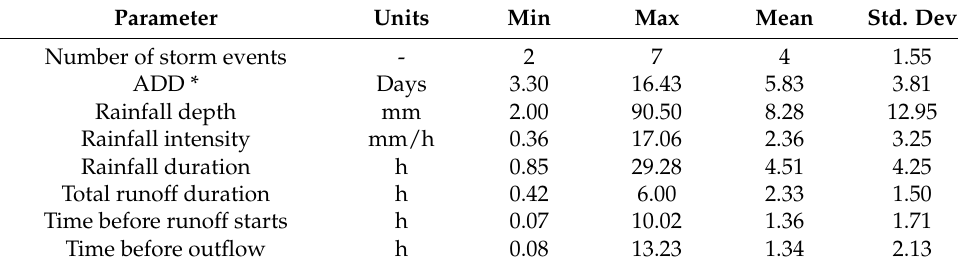
Table 3. Hydrological characteristics of the monitored events.